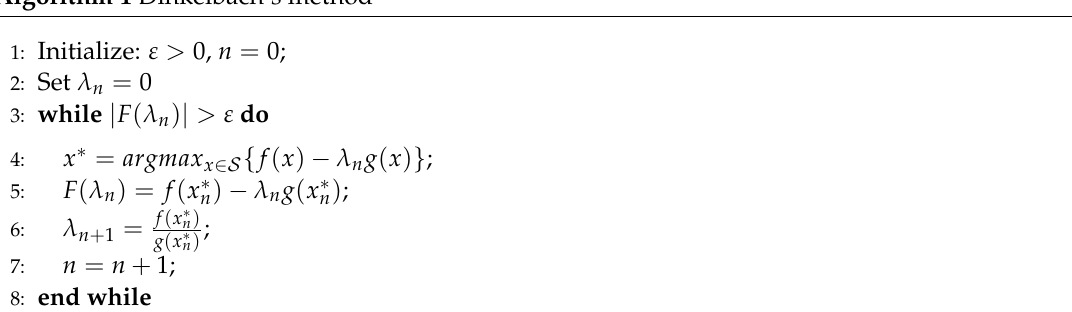
Algorithm 1 Dinkelbach’s method